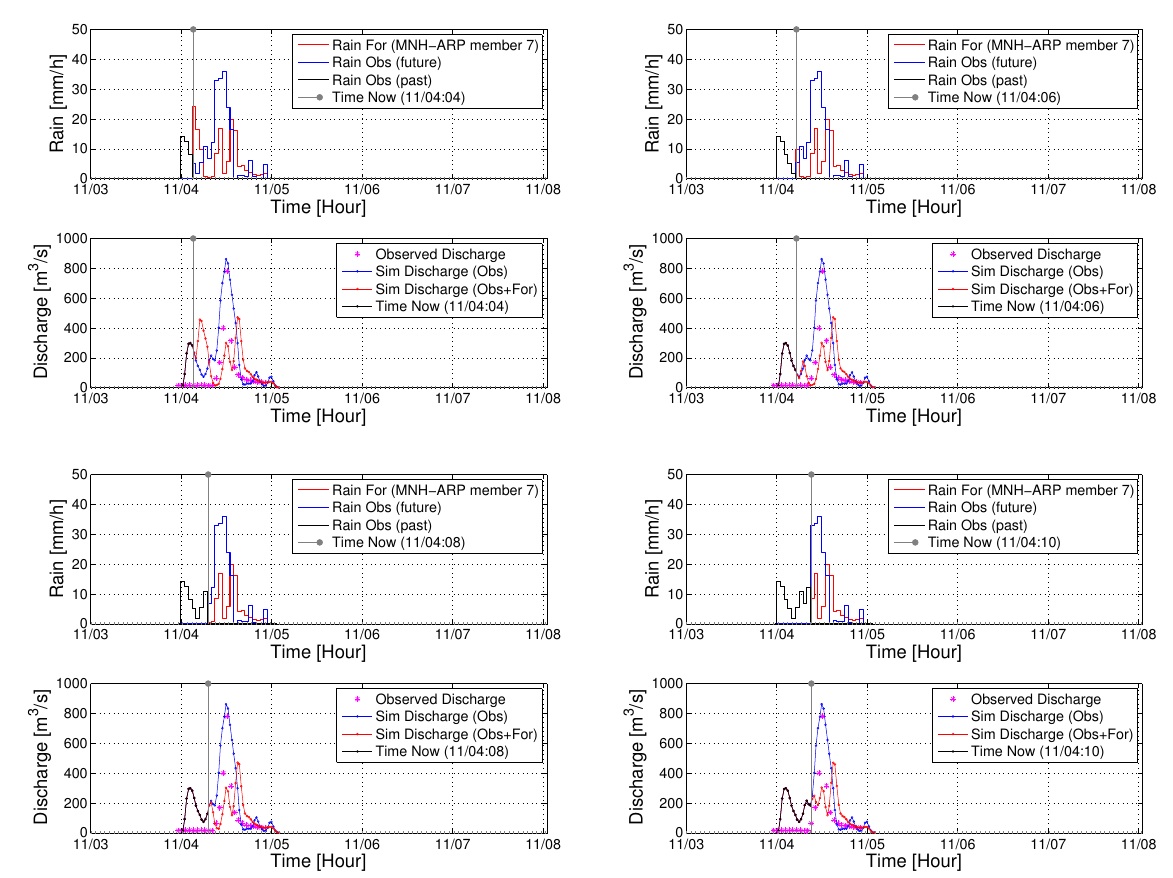
Figure 13. Emulation of real-time forecasting mode, combining observed rainfall and modelled rainfall. The RIBS model is forced with observed rainfall until current time and forecasted rainfall from one of the Meso-NH ensemble members. Four time steps are presented: at 04:00UTC (upper left panel), at 06:00UTC (upper right panel), at 08:00UTC (lower left panel) and at 10:00UTC (lower right